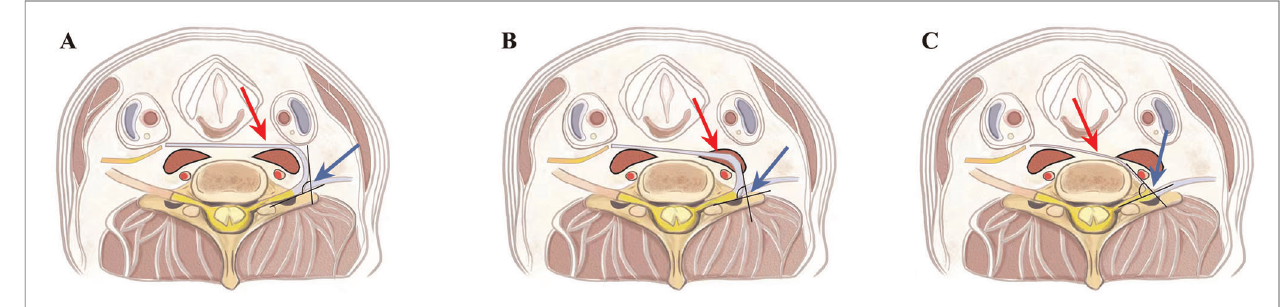
FIGURE 4 | The included angle of CC7 nerve transfer via three prespinal routes: ( A ) anterior route, ( B ) middle route, ( C ) posterior